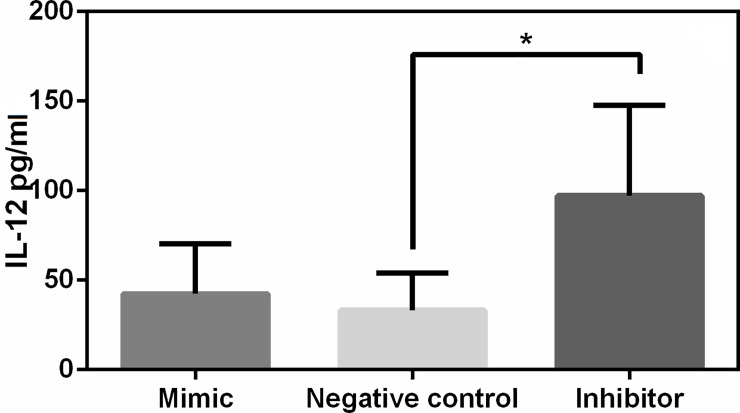
IL-12 production.IL-12 production was quantified in supernatants from SL cultures of dogs transfected with negative control (scrambled), miR 21 mimic, miR 21 inhibitor, all in the presence of Hiperfect (miScript miRNA Mimic and Inhibitor Qiagen, USA), following 67h in culture. SL from dogs naturally infected by L. infantum. Data represent the mean values of IL-12 + SE. Asterisks represent significance (p<0.05) by Friedman Test with multiple comparison.